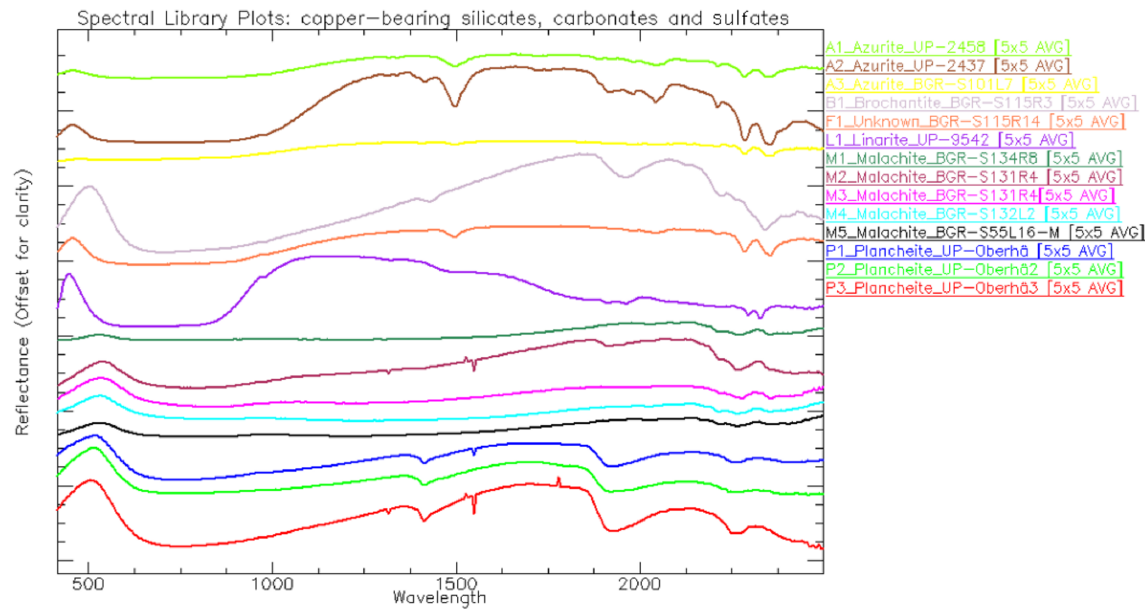
Figure 11. Spectral library plot of the copper-bearing minerals – silicates, carbonates and sulfates.